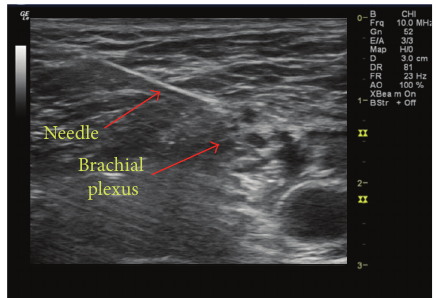
Figure 1: Ultrasound image of low interscalene block.